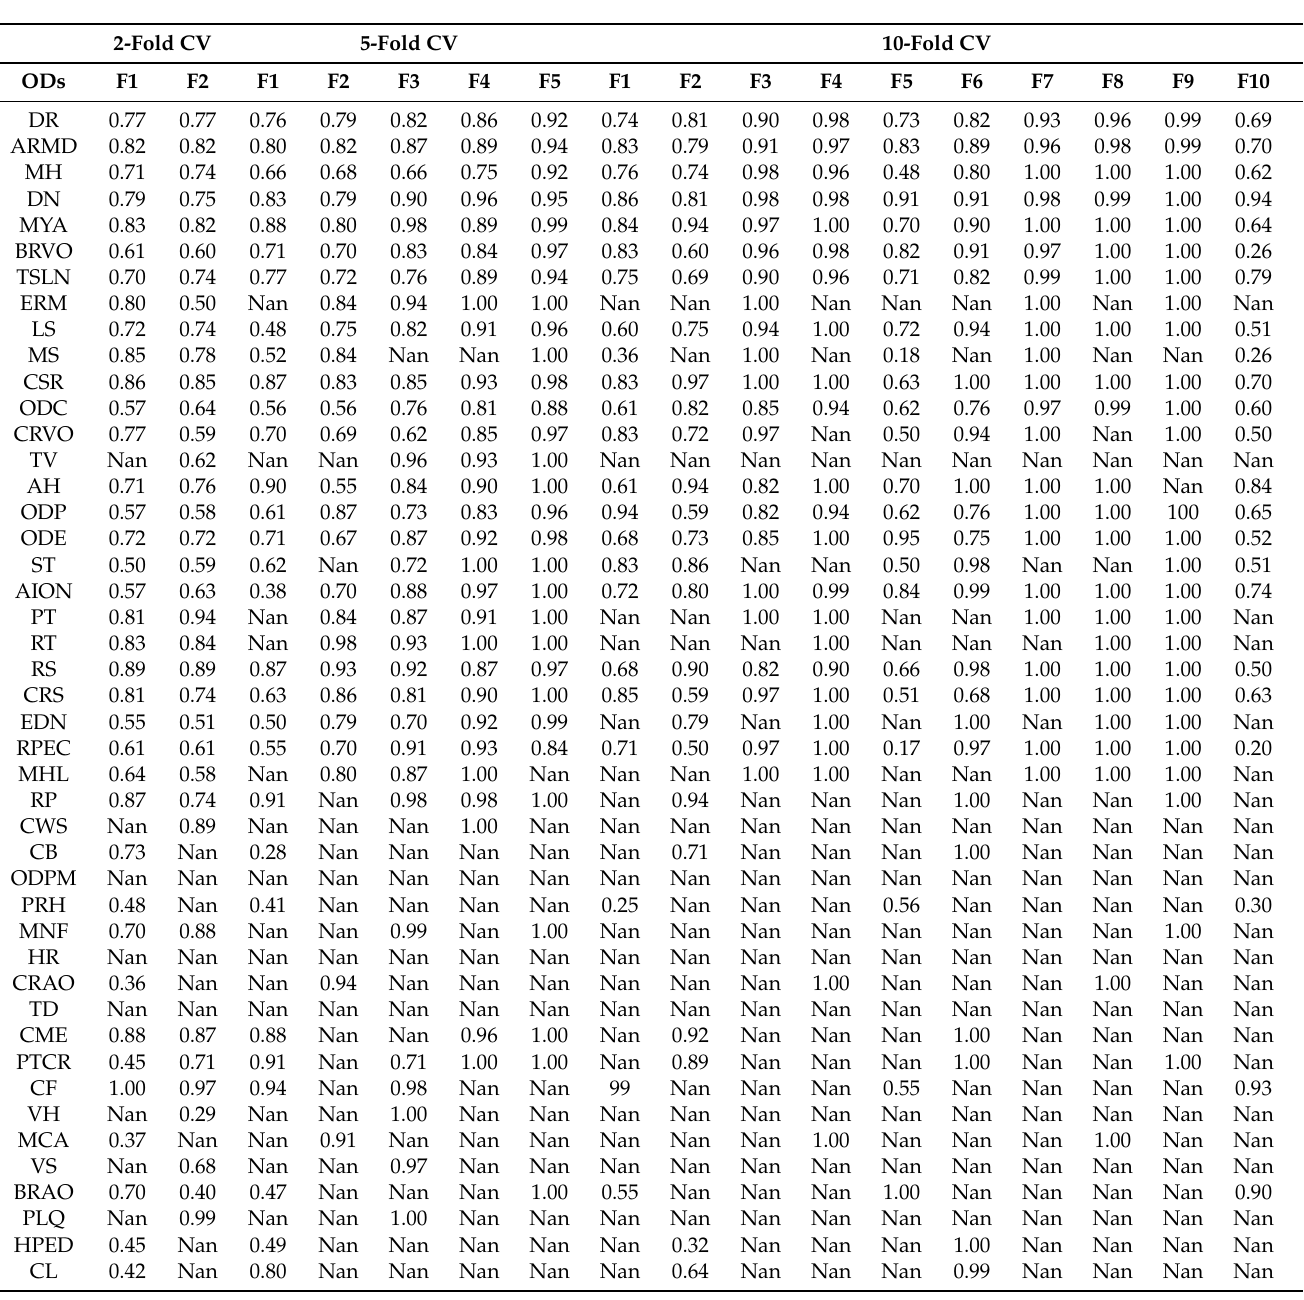
Table 10. AUC of all 45 ODs by using 2-, 5-, and 10-fold